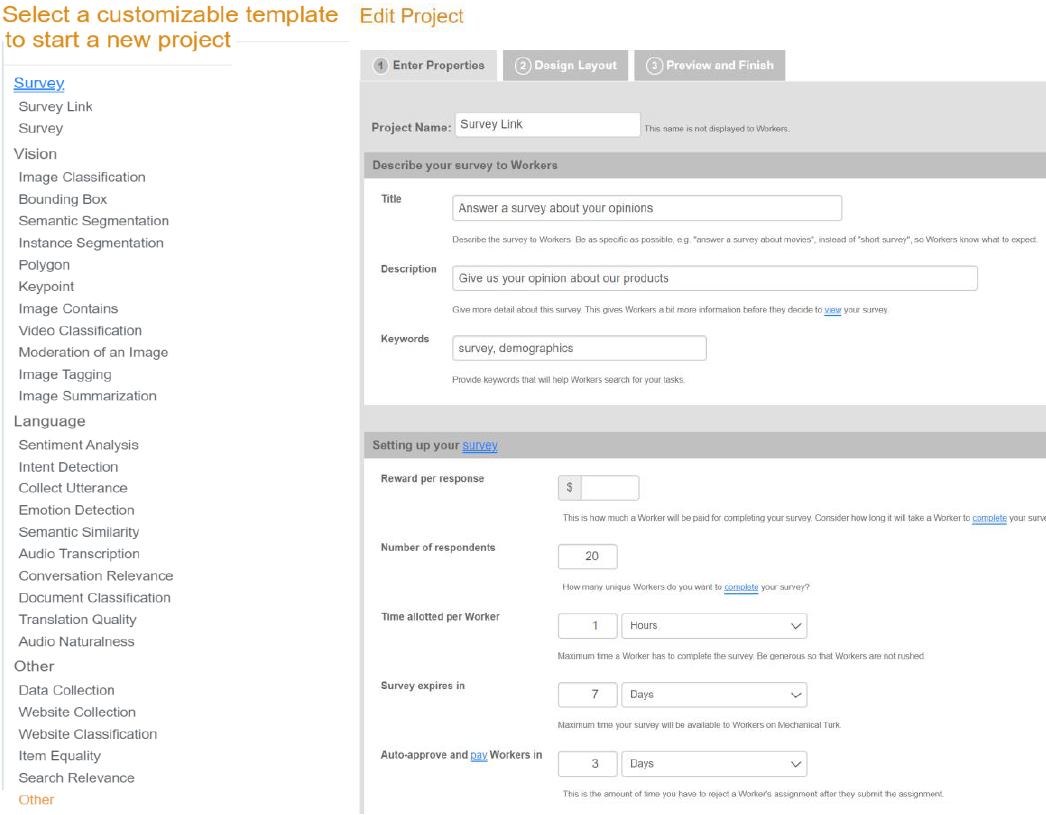
Figure 11. Project type specification in Amazon Mechanical Turk.